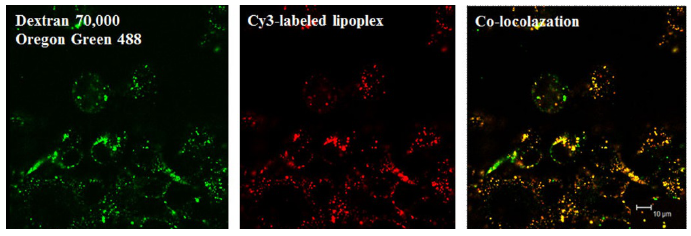
Figure S1. Cellular uptake of the liposome B/DNA complex. We examined the colocalization of lipoplexes with Oregon Green 488-labeled dextran 70,000 molecular weight (dextran 70,000), a known macropinocytic pathway marker. COS-7 cells were incubated with dextran 70,000 ( green ) and lipoplex B containing Cy3-labeled DNA ( red ). Images were obtained using confocal microscopy 1 h after transfection. Scale bar: 10